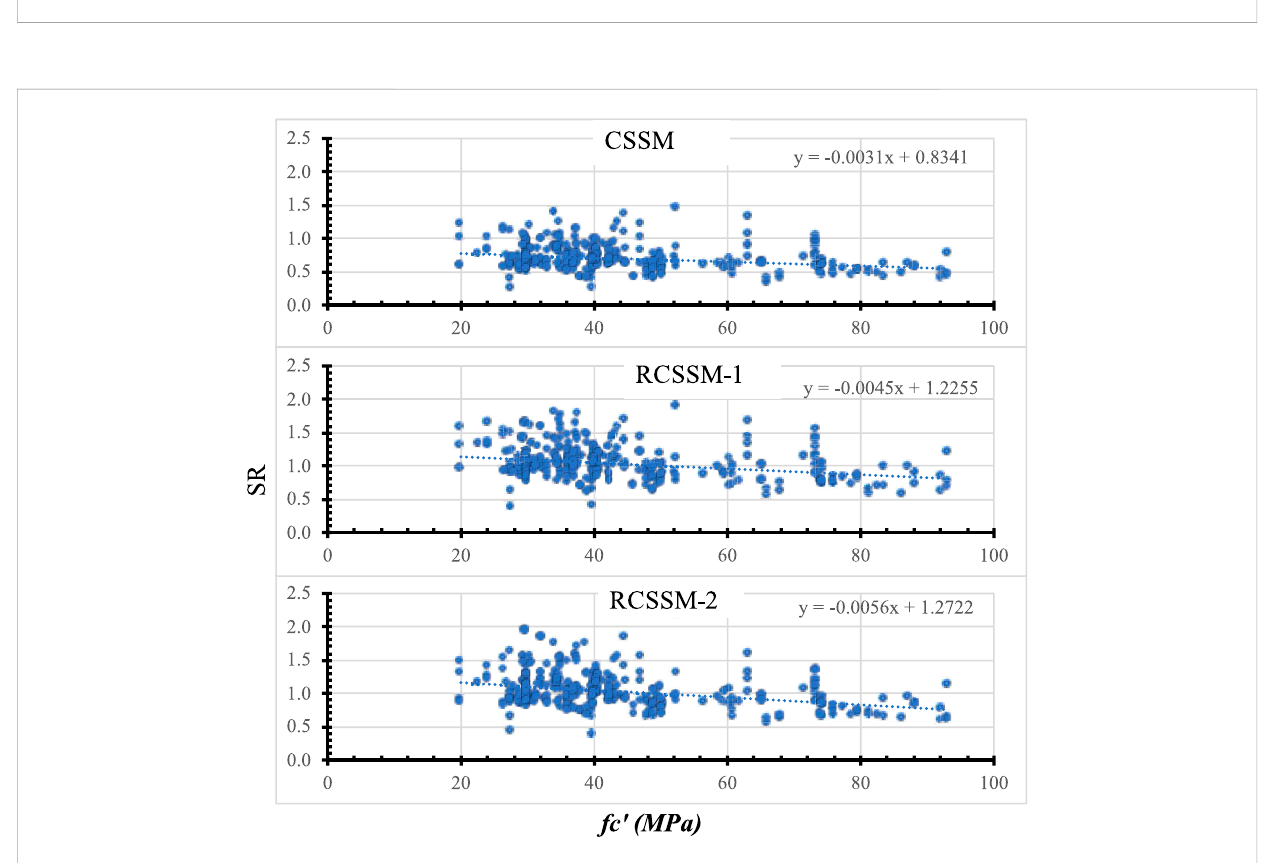
FIGURE 13 SR calculated using proposed models versus concrete compressive